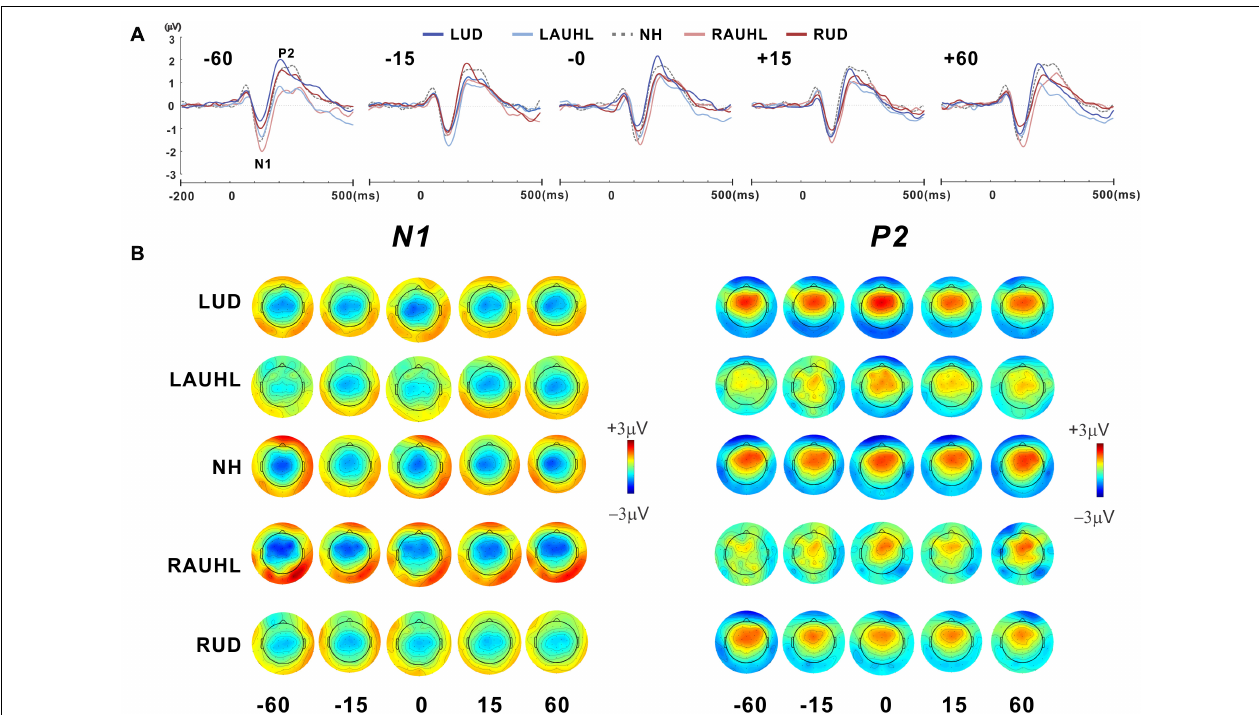
FIGURE 3 | (A) Grand mean waveforms at five different azimuth angles (–60 ◦ , –15 ◦ , 0 ◦ , +15 ◦ , and +60 ◦ ) for the subject groups recorded with fronto-central (FC) electrodes under the passive listening condition. (B) Topographical representation of the N1 and P2 responses as a function of azimuth angle for each subject group. RUD, right-sided unilaterally deaf; LUD, left-sided unilaterally deaf; RAUHL, right-sided acute unilateral hearing loss; LAUHL, left-sided acute unilateral hearing loss; NH, normal